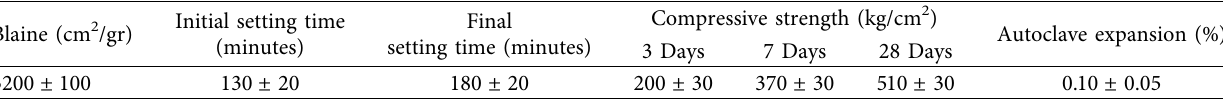
Table 1: Physical characteristics of type 2 Portland cement.